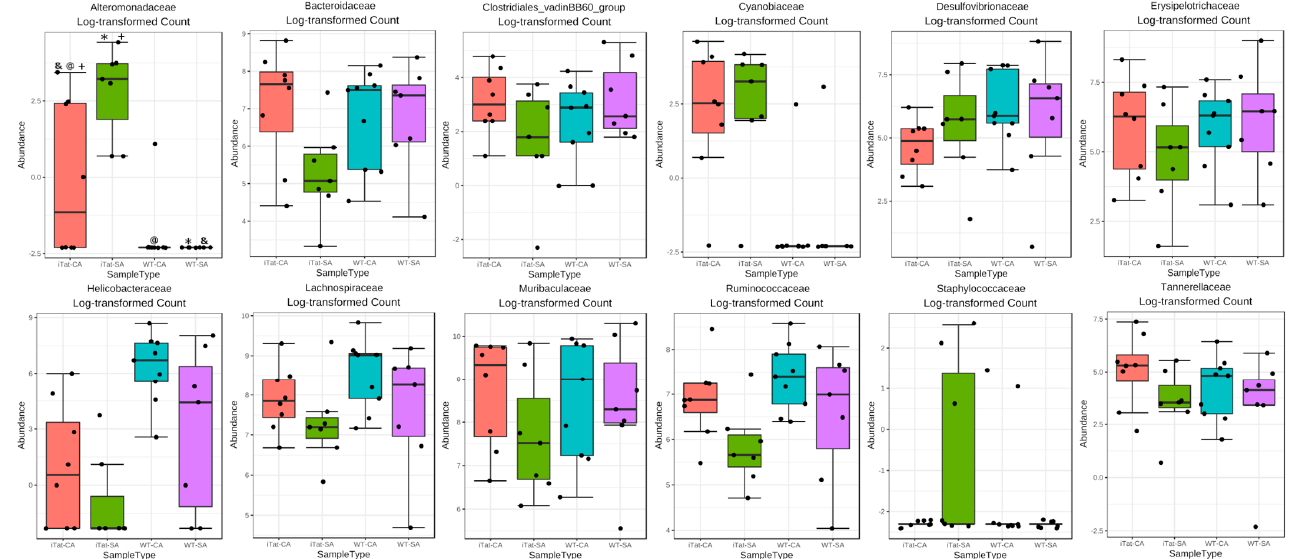
Figure 2. Effects of Tat expression and cocaine exposure on microbial abundance by family in the gut of 6-month female mice. Twelve families which were affected in either group were presented. The data were analyzed using Kruskal–Wallis test, followed by post hoc Games–Howell’s test. The family which was affected by Tat expression and/or cocaine exposure was marked in red. The error bars were SD, and “*”, “&”, “@” or “+” denoted p < 0.05.